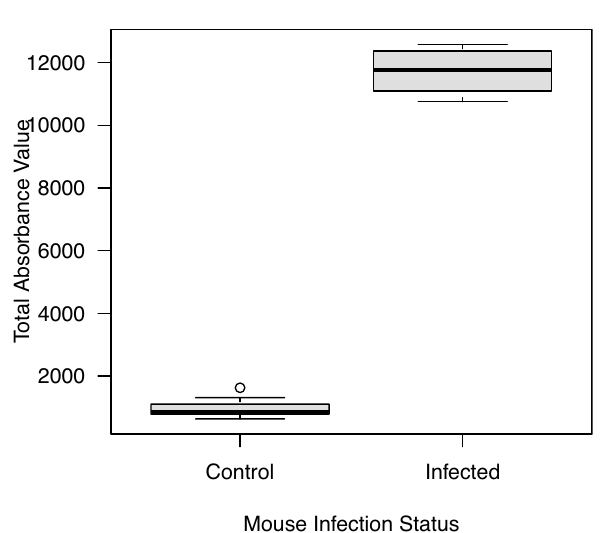
Figure 3. Borrelia afzelii induces a strong IgG antibody response in the infected mice compared to the uninfected control mice. The total absorbance values were obtained from a commercially available ELISA that measured the strength of the IgG antibody response against B. afzelii . The mean IgG antibody response against B. afzelii of the infected mice (11,749 absorbance units (AU)) was 12.9 times higher compared to the control mice (912 AU), and this difference was highly significant (p < 0.000001). The boxplots show the median (black line), 25th and 75th percentiles (edges of the box), minimum and maximum values (whiskers), and outliers (open